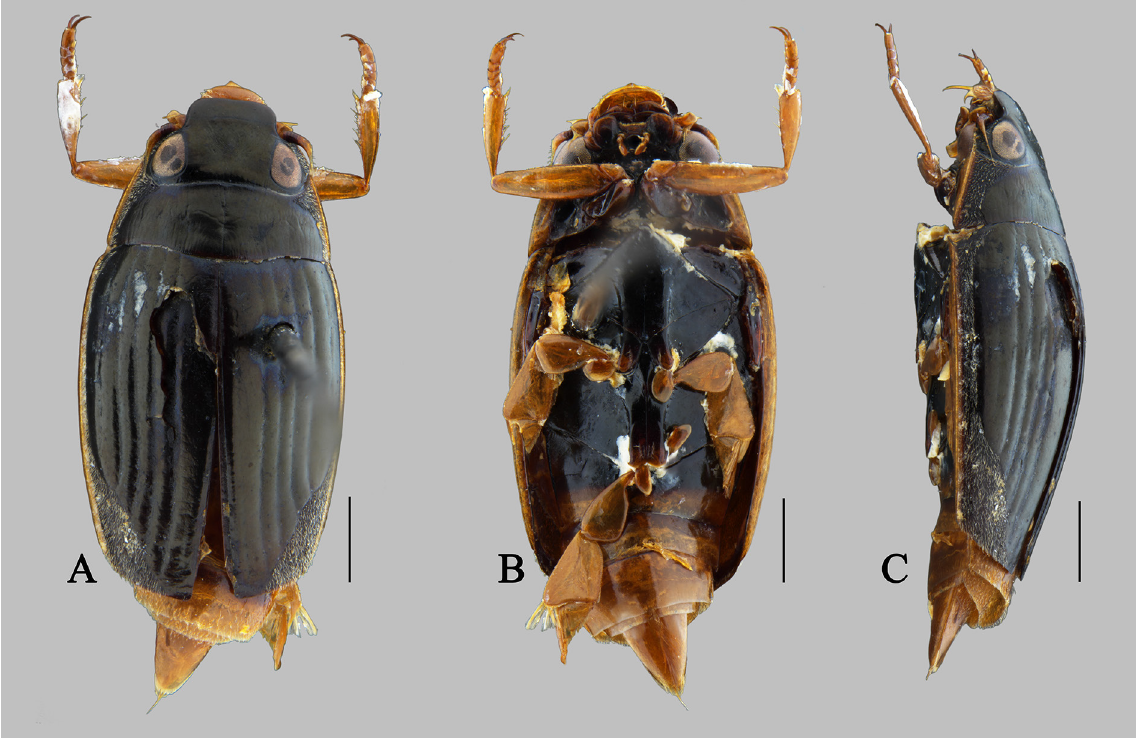
Fig. 15. Patrus marginepennis angustilimbus (Ochs, 1925), ♀, habitus (IZCAS). A . Dorsal view. B . Ventral view. C . Lateral view. Scale bars = 1